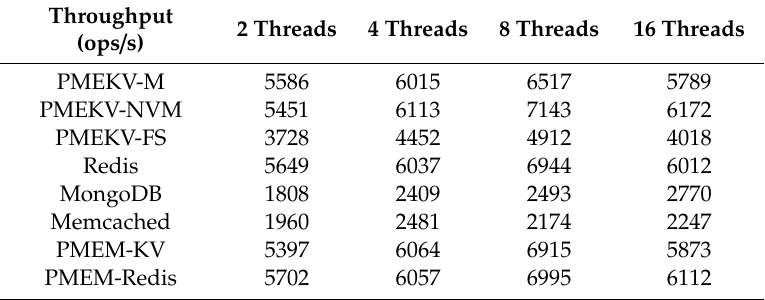
Table 2. The throughput of key–value pairs insert with multi-threads.